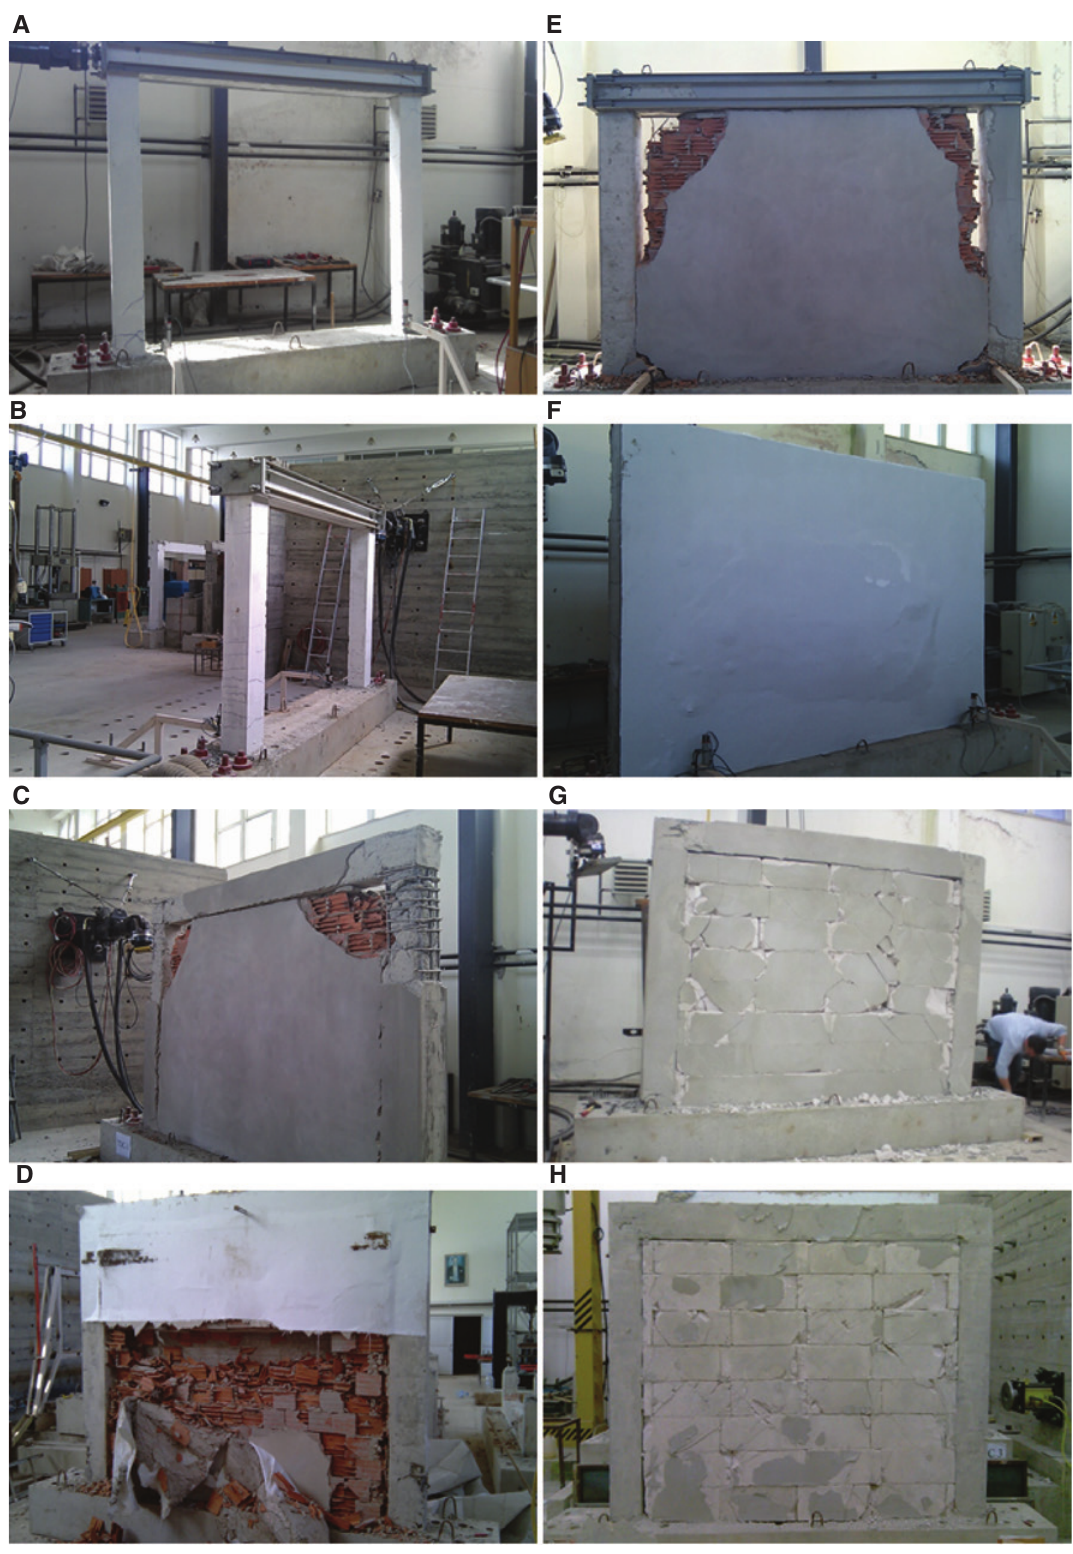
Figure 16: Failure patterns of the test frames. (A) PRCF-1, (B) PRCF-2, (C) RCF-1, (D) RCF-2, (E) RCF-3, (F) RCF-4, (G) RCF-5, (H)